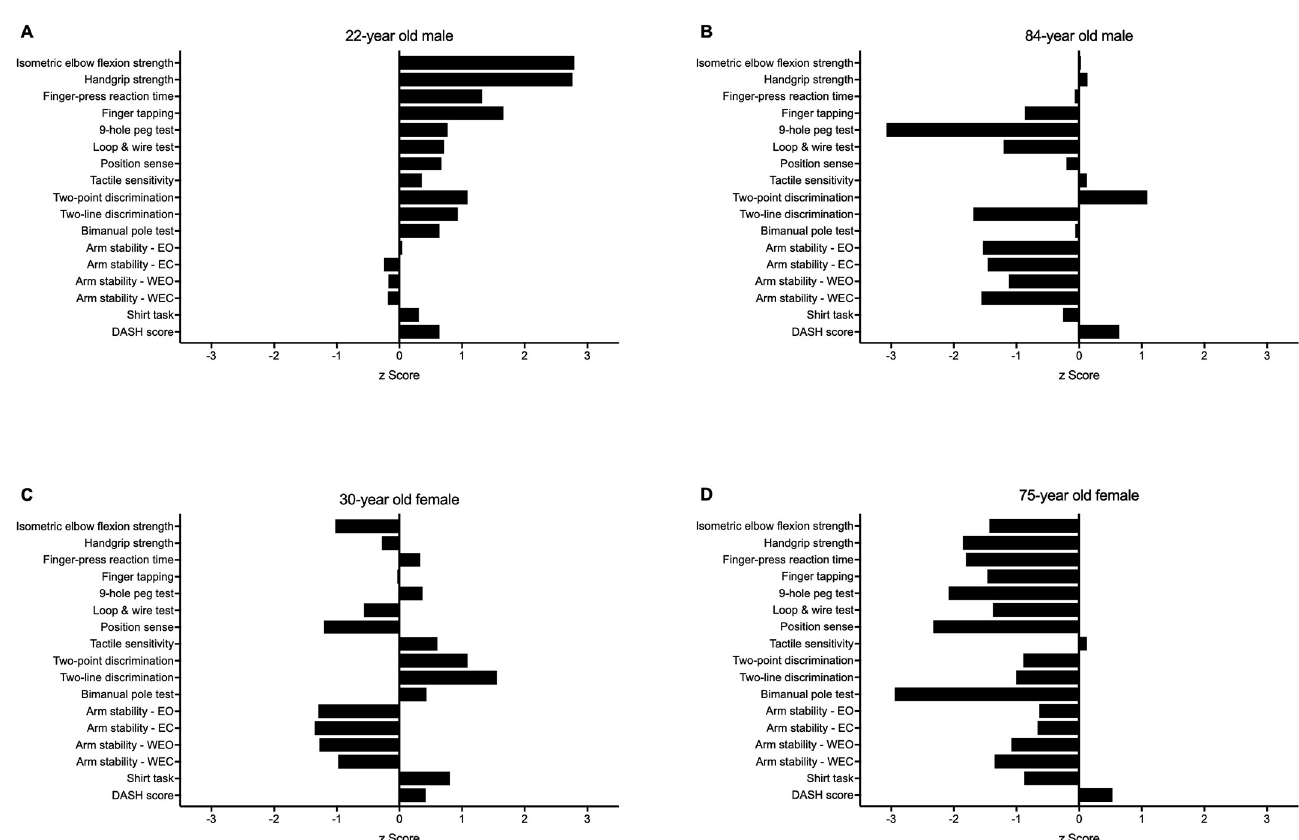
Fig 11. Upper limb Physiological Profile Assessment (PPA) z-score output for four participants. Test scores are presented as standardised (z) scores, referenced to the entire sample, to allow direct comparison in performance between each test both within and between individuals. Each unit represents one standard deviation. A score of zero indicates an average level of performance compared to the study population, while positive and negative scores represent above- and below-average performances respectively. (A) A 22-year old male who, in general, performed well above average in the majority of tests. (B) An 84-year old male with below average levels of coordination and arm stability, while maintaining average levels of muscle strength. (C) A 30-year old female demonstrating above average skin sensibility, but below average levels of muscle strength and arm stability. (D) A 75-year old female who performed below average in most